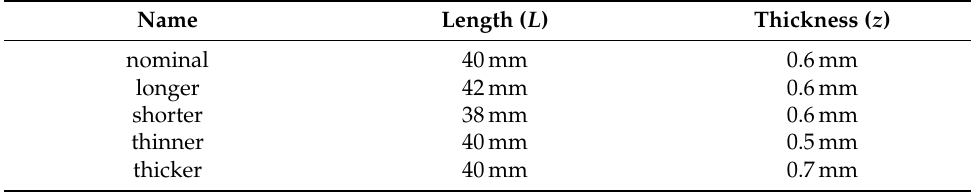
Table 2. The various coil models in the